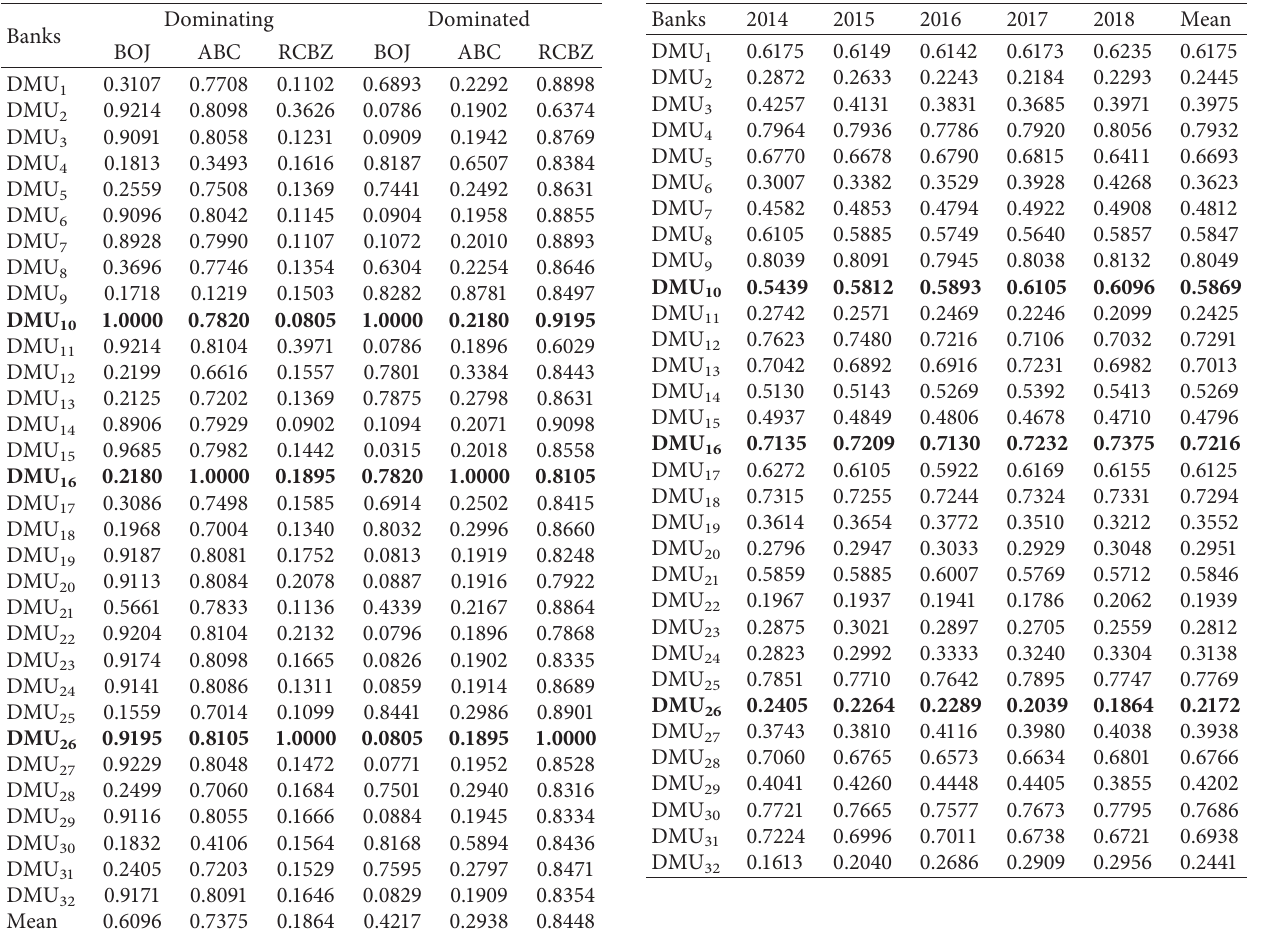
Table 7: Inefficiency dominance probability of 32 listed banks